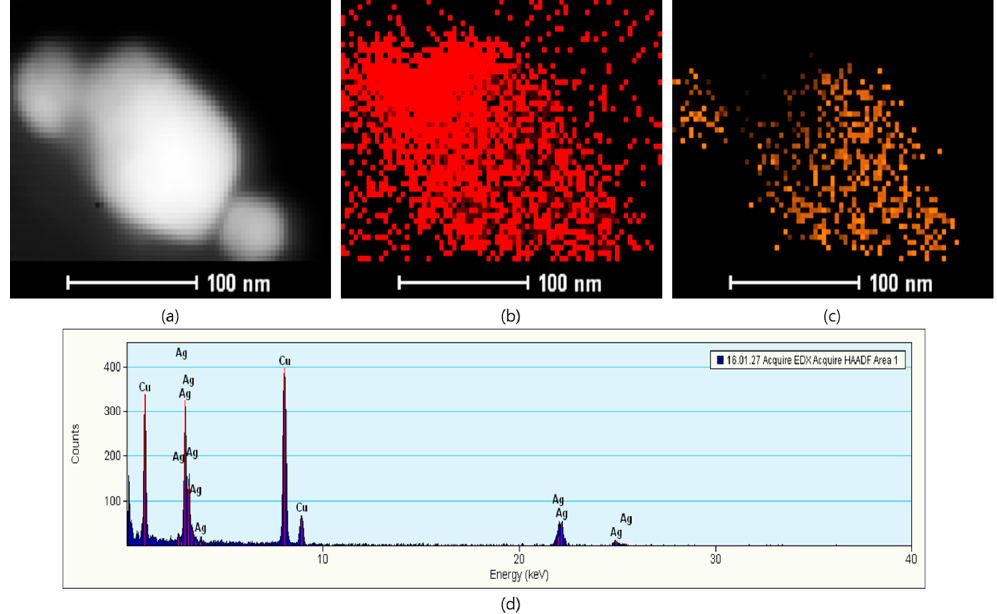
Figure 4. STEM-HAADF, elemental mapping, and EDX spectrum of copper-silver bimetallic nanostructures: ( a ) STEM-HAADF image; ( b ) copper; ( c ) silver; and, ( d ) EDX spectrum. Generally, the qualitative and quantitative analysis of the material’s homogeneity was studied by the Fourier transform infrared (FT-IR). FTIR spectroscopy is a significant technique for studying the role of hexadecylamine (HDA) in the synthesis of Cu-Ag bimetallic nanostructures and their surface environments. It can be seen from Figure 5 that the N-H stretching produces symmetrical (3329 cm − 1 ), asymmetrical (3251 and 3153 cm − 1 ) stretching vibration peaks, and the vibration modes at 2918 and 2854 cm − 1 are correspondingly assigned to the C-H stretching terminal modes of the CH 3 and CH 2 group alkyl chains of HDA [32]. The peak that was obtained at 1607 cm − 1 is related to the vibration modes of N-H bending and modes at 1464 and 1362 cm − 1 are related to the C-H bending vibration modes of the CH 3 and CH 2 , respectively [33]. For the bimetallic nanostructures of Cu-Ag, there is a lower wavenumber of about 45 cm − 1 due to the binding of the amine group that was adsorbed on the HDA surface of the bimetallic nanostructures of Cu-Ag, indicating that the organic residue is part of the fabrication of bimetallic nanostructures [34].